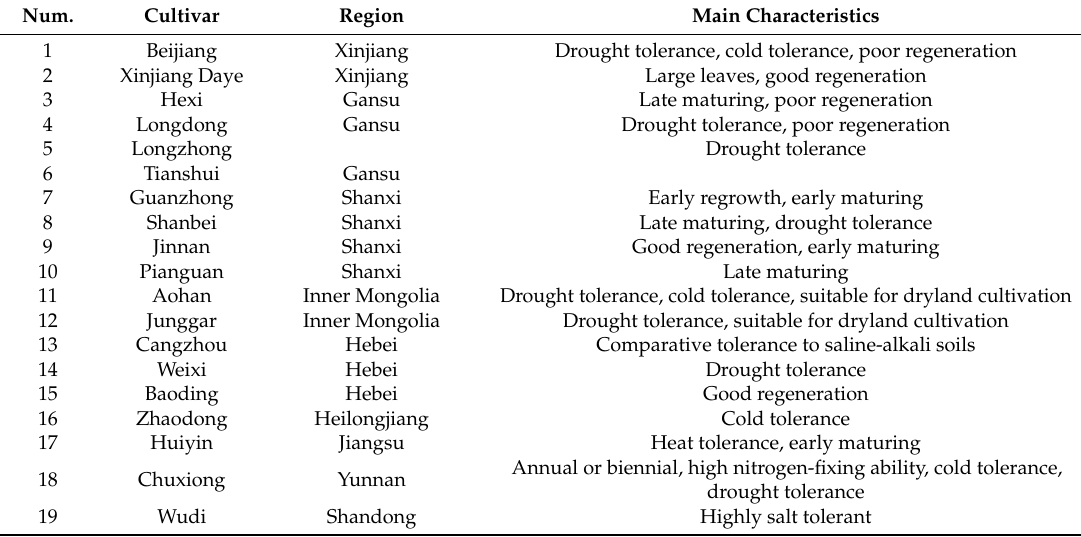
Table 2. Local alfalfa varieties registered by the National Committee for the Examination and Approval of Herbage Varieties.